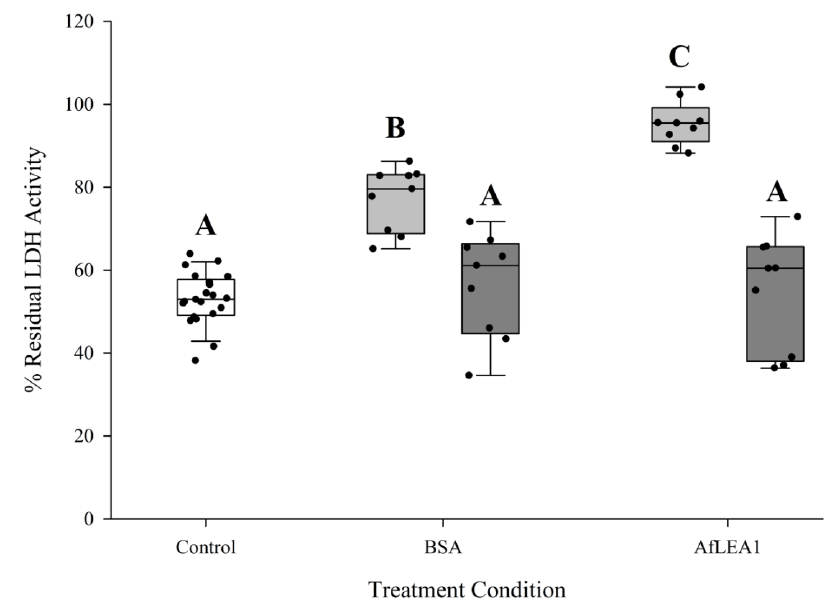
Figure 11. Residual activity of purified LDH was significantly increased when desiccated in the presence of BSA or Af LEA1 and then rehydrated with 100 mM sodium phosphate buffer at pH 6.5 (light gray box plots). LDH activity was not restored after desiccation in the absence of BSA or Af LEA1, and then rehydrated with 100 mM sodium phosphate buffer at pH 6.5 containing BSA or Af LEA1 (dark gray box plots). Control samples (white box plot) were desiccated and rehydrated in the absence of BSA or Af LEA1 ( n = 9-18; ± SD, p < 0.05; different letters indicate significant differences between